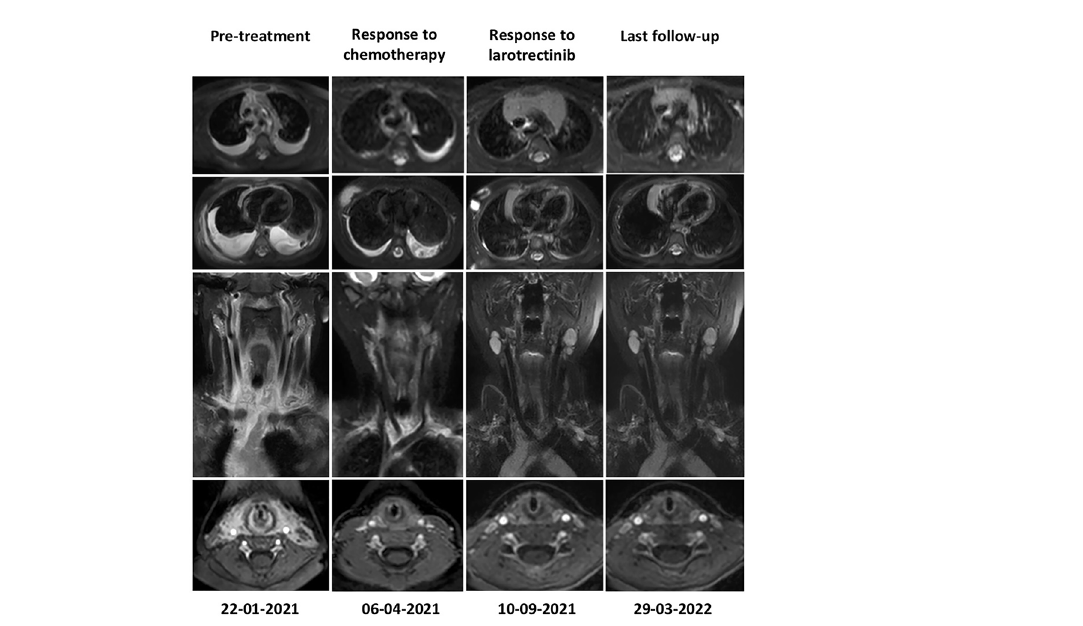
FIGURE 3 Radiological response as determined by Magnetic Resonance imaging before treatment (22.01.21), following administration of the CWS 2012 protocol (06.04.21) and NTRK inhibitor therapy (Larotrectinib) (10.09.21), respectively. Follow-up MRI is performed every three months; the latest images show a sustained response to Larotrectinib therapy as no visible tumour mass is detectable (29.03.22). While a limited therapeutic response upon completion of chemotherapy, a remarkable and sustained complete remission from Larotrectinib was